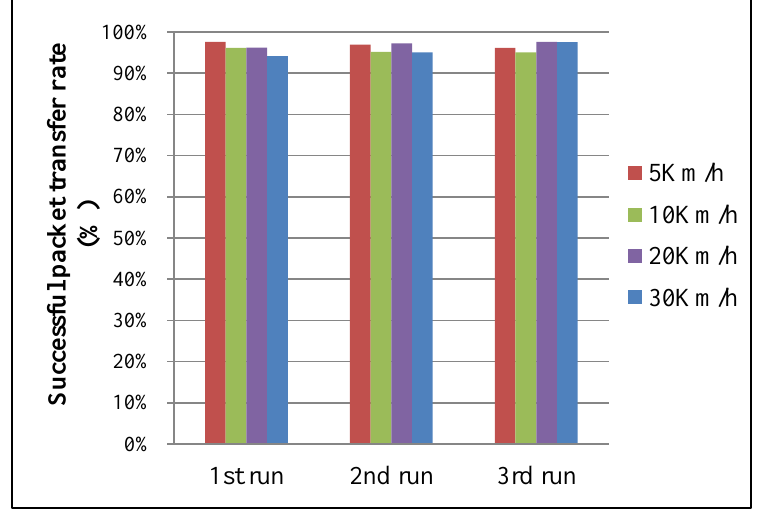
Figure 13. Average successful packet transfer rate according to changes in the mobile nodes’